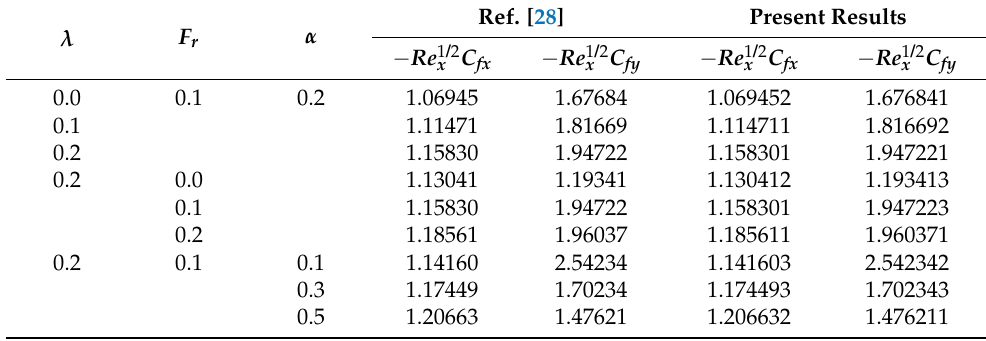
Table 1. Numerical values of skin friction coefficients for different values of